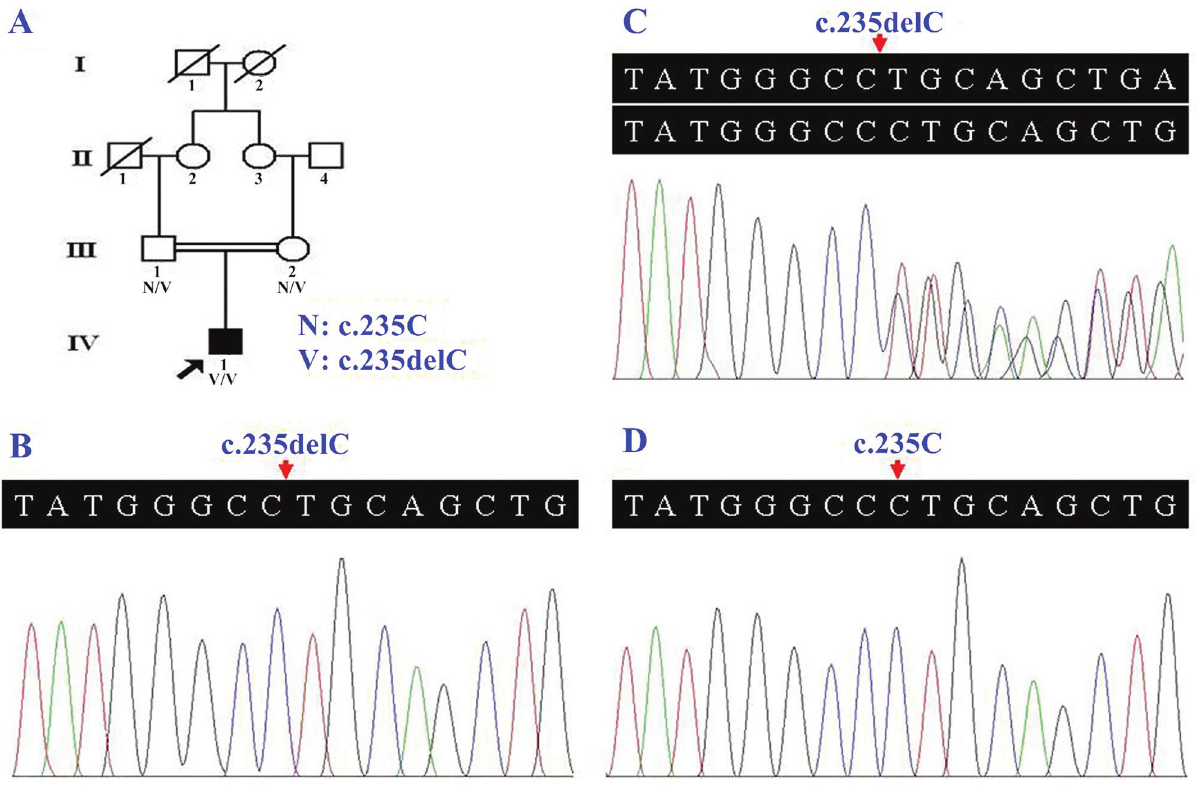
Figure 1 - Pedigree of the Han Chinese individual with nonsyndromic hearing loss, and the GJB2 Sanger sequencing electropherograms. (A) The patient was born to first-cousin normal-hearing parents. (B) Homozygosity for the GJB2 c.235delC variant in the individual with hearing loss (IV:1). (C) The heterozygosity for the GJB2 c.235delC variant in the normal-hearing father (III:1). (D) The GJB2 sequence in a normal